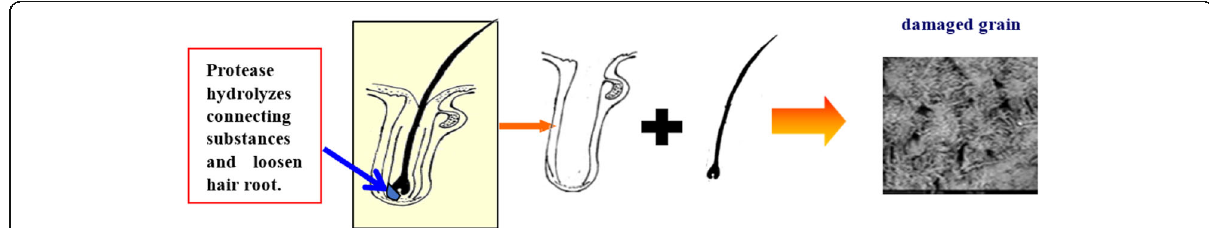
Fig. 3 The mechanism of protease